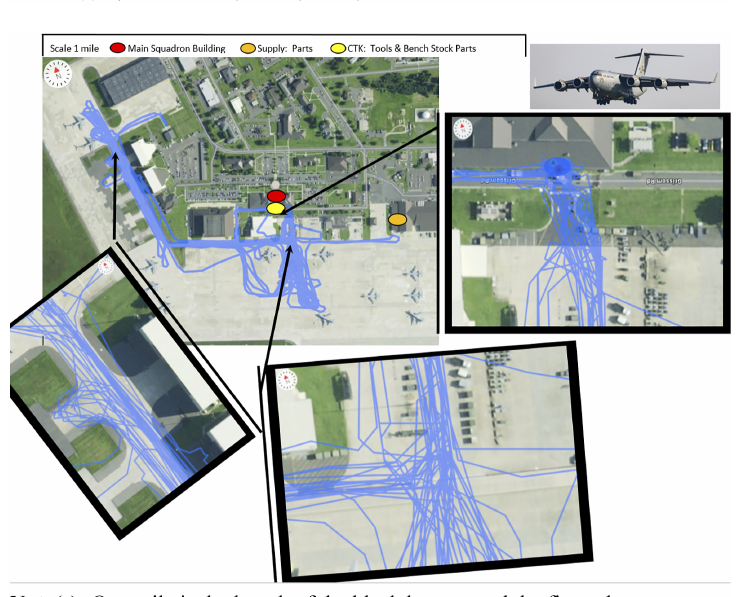
Figure 2. Spaghetti diagram: GPS tracking of ride- along with C-17 expediter at JB MDL,